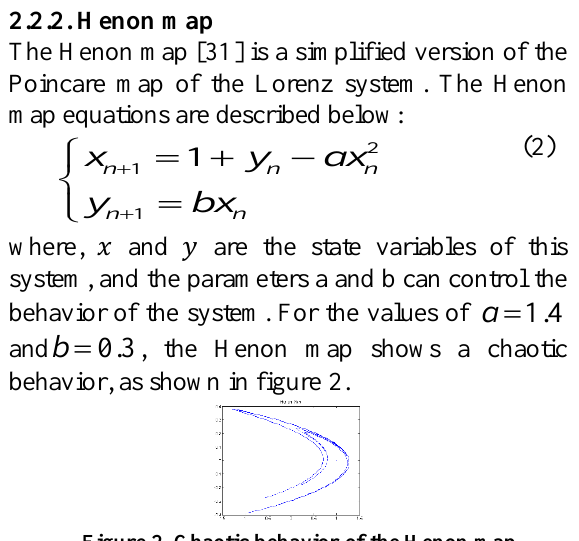
Figure 2. Chaotic behavior of the Henon